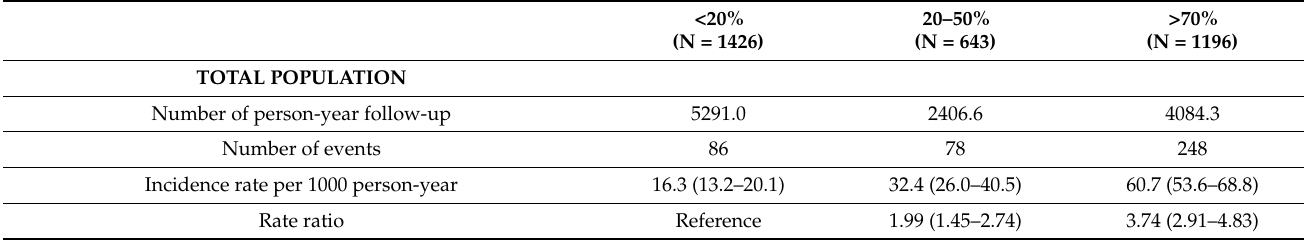
Table 2. The risk of cardiovascular event according to the degree of coronary artery